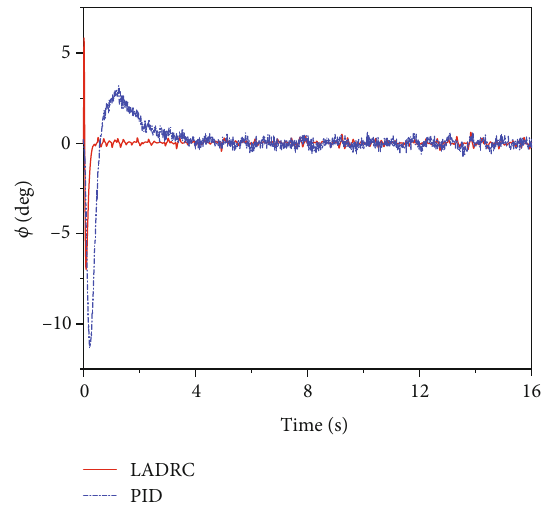
Figure 8: Response of the roll